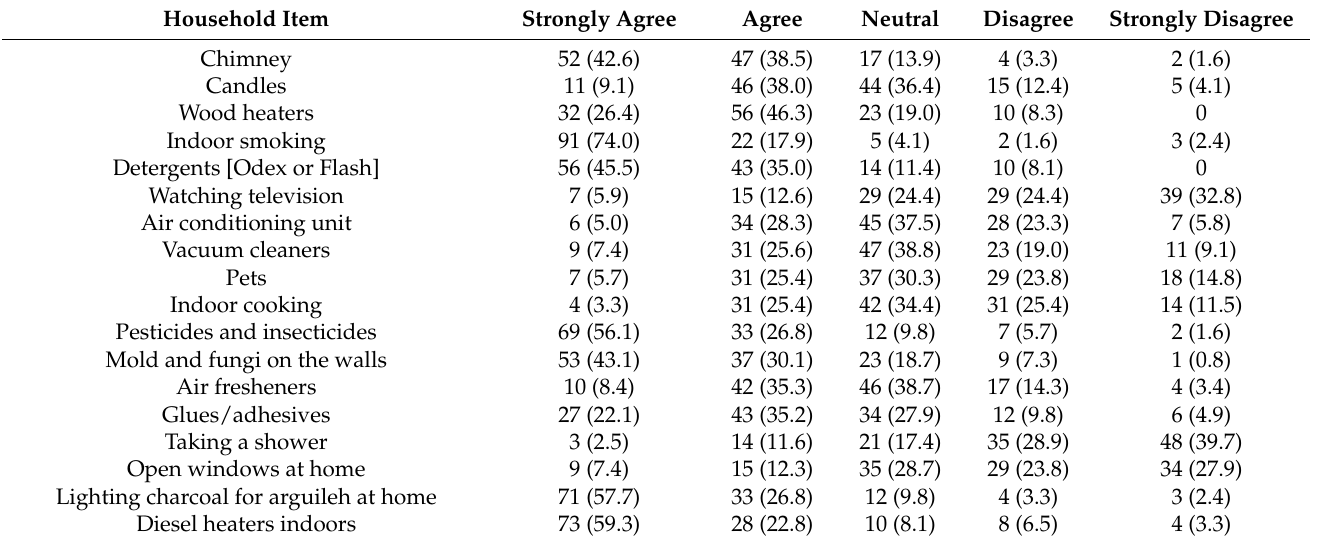
Table 4. Answers to the question “To what extent do you agree that each of the below household items or activities is associated with exposure to air pollution”? The answers are reported as true counts